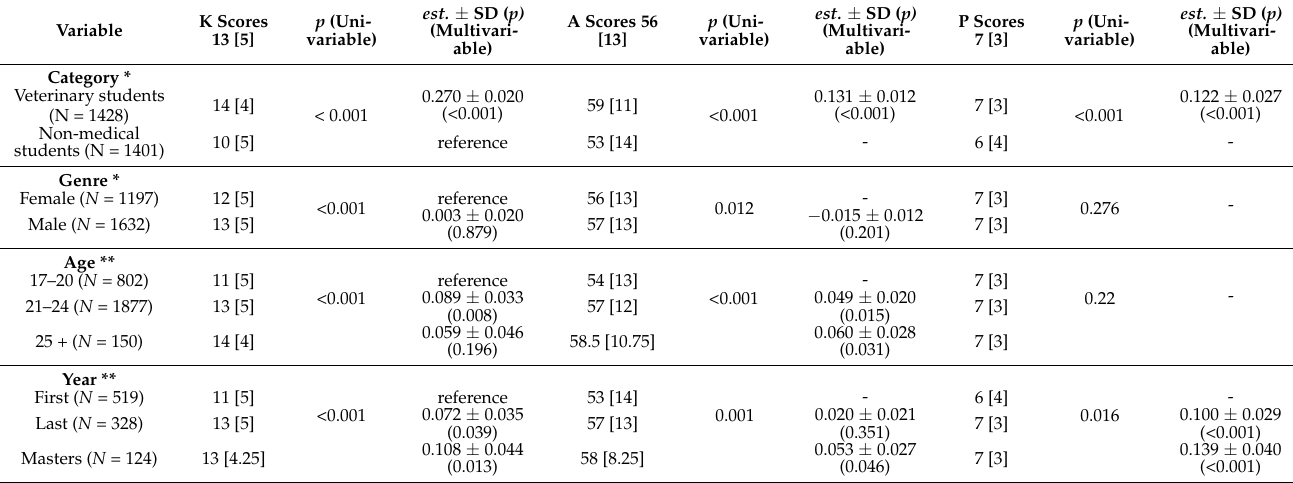
Table 7. Knowledge (K), attitudes (A) and practices (P) scores with respect to demographics.